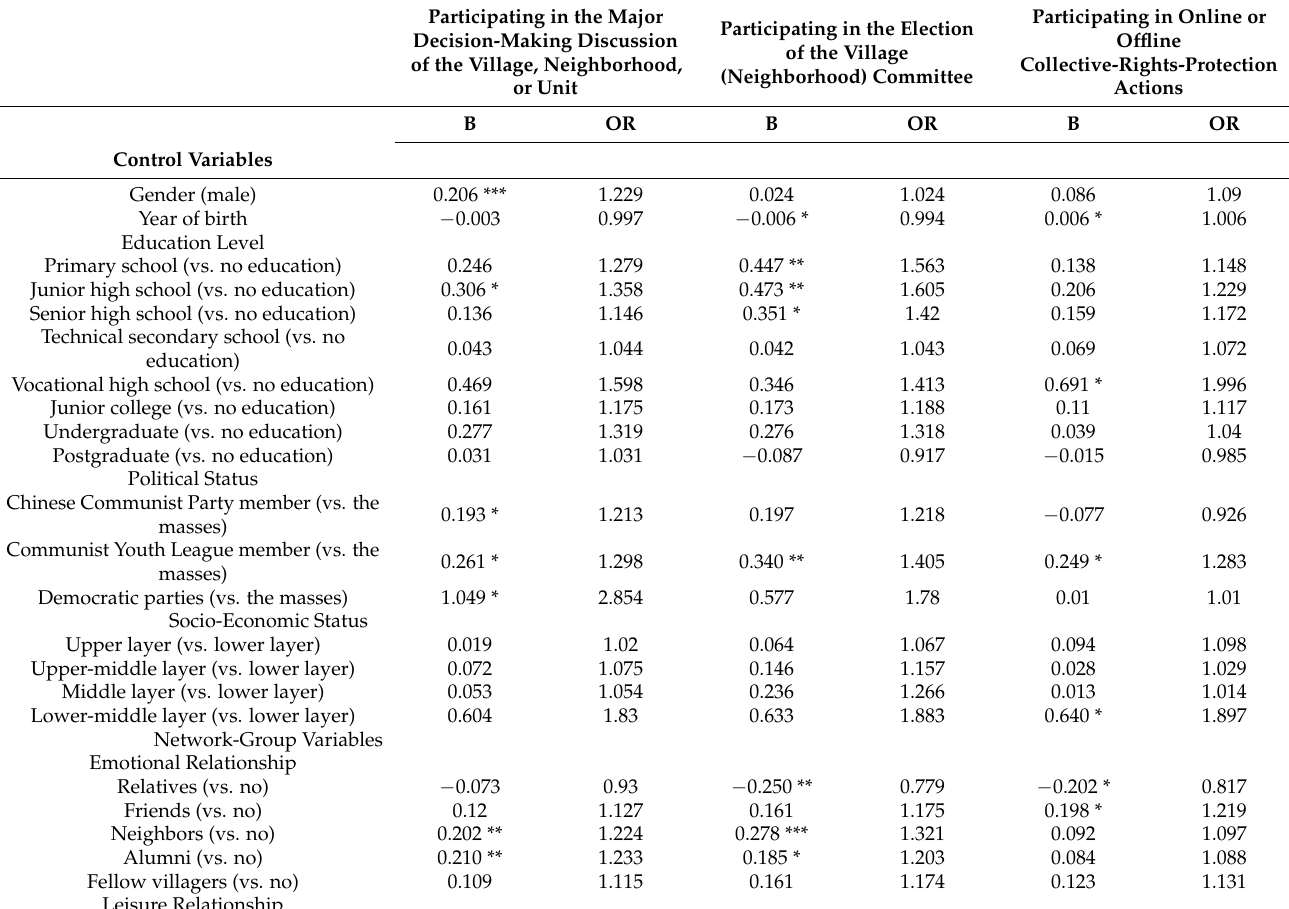
Table 1. Results of hierarchical logistic regression of direct political